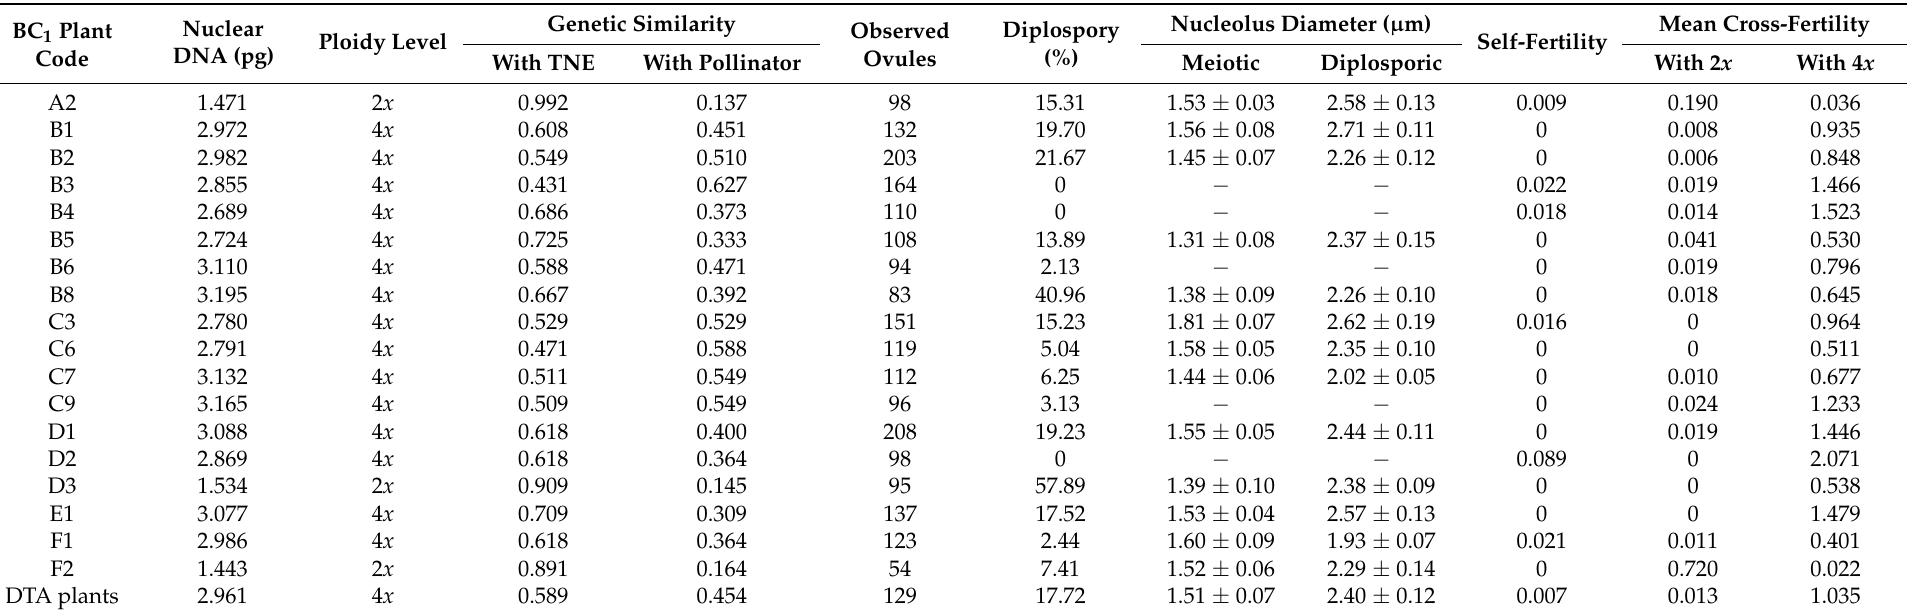
Table 1. Information on BC 1 plants, including nuclear DNA content, ploidy level, and genetic similarities with 2 n gamete producers, along with reproductive behavior (these data have been retrieved, computed, or adapted from